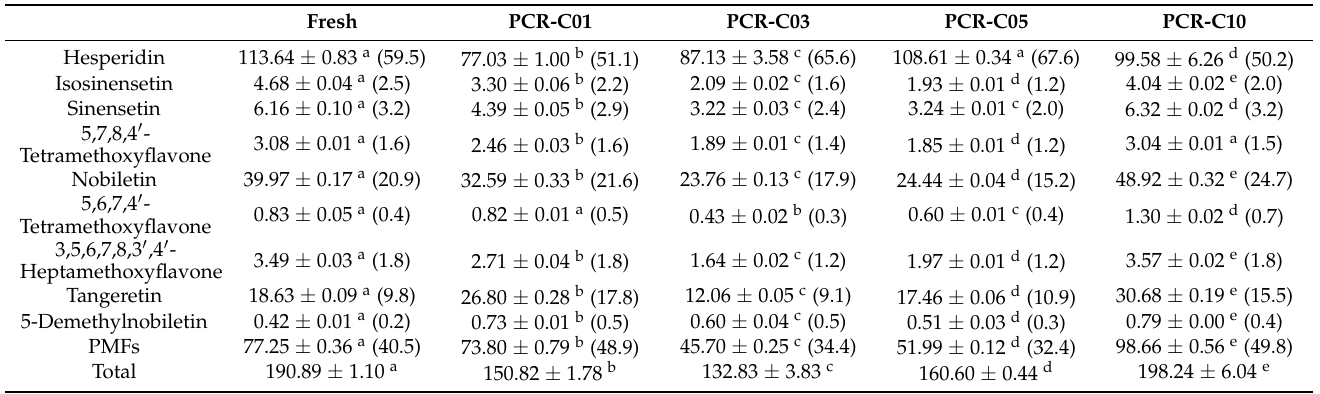
Table 4. The contents of nine main flavonoids in PCR-C samples after